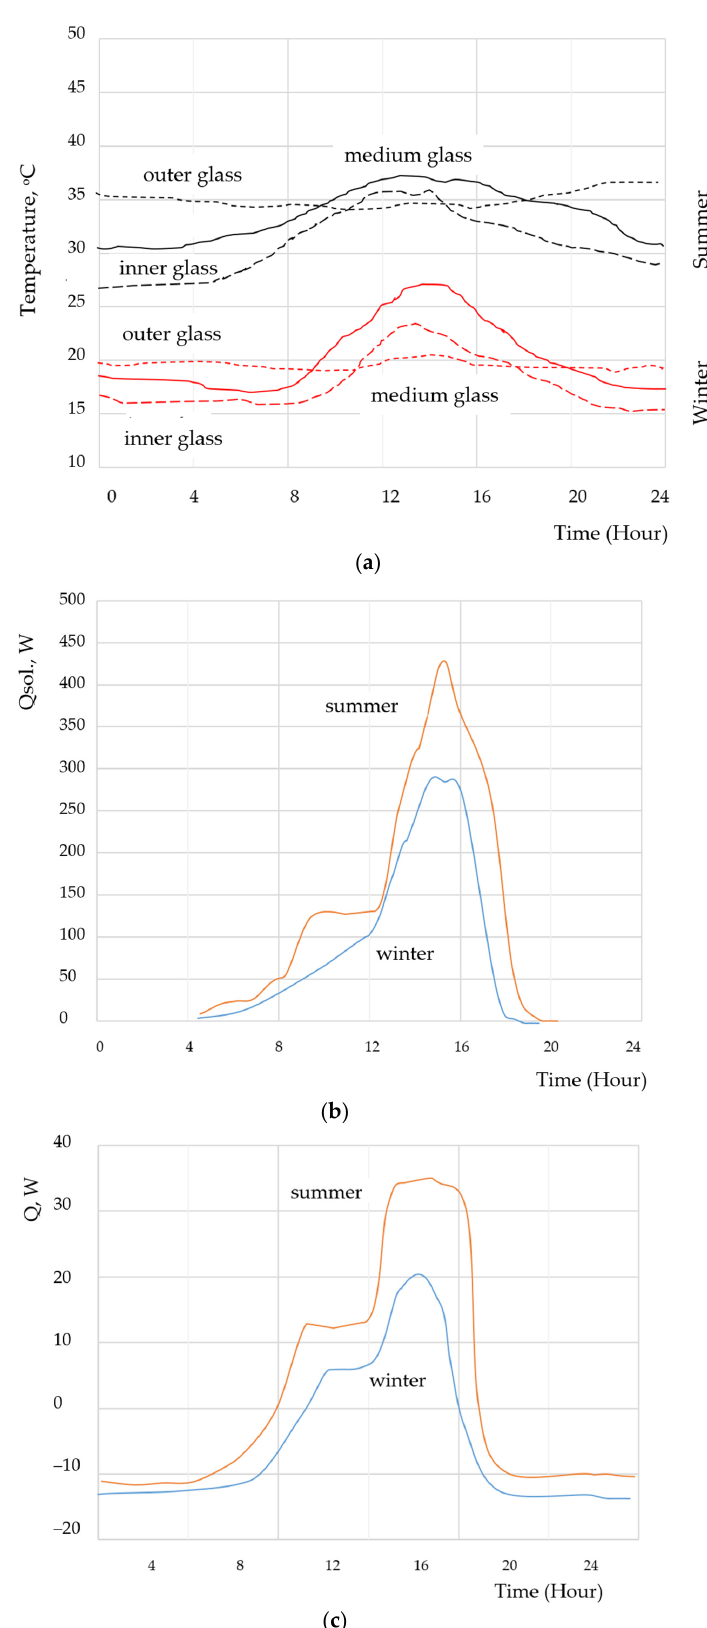
Figure 7. ( a ) The temperature on the surface of window panes; ( b ) the solar heat gains; ( c ) the heat fluxes from the simulation in the summer and the winter (data obtained as a result of processing cited papers).